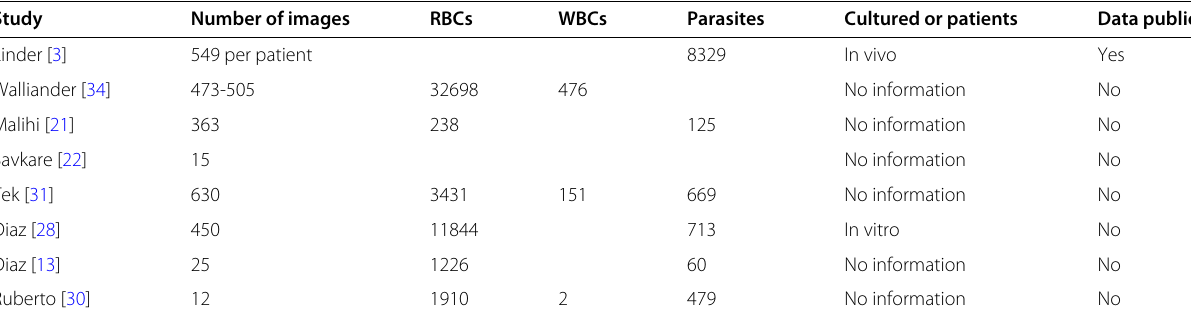
Table 1 Data sets. RBCs = red blood cells, WBCs = white blood cells